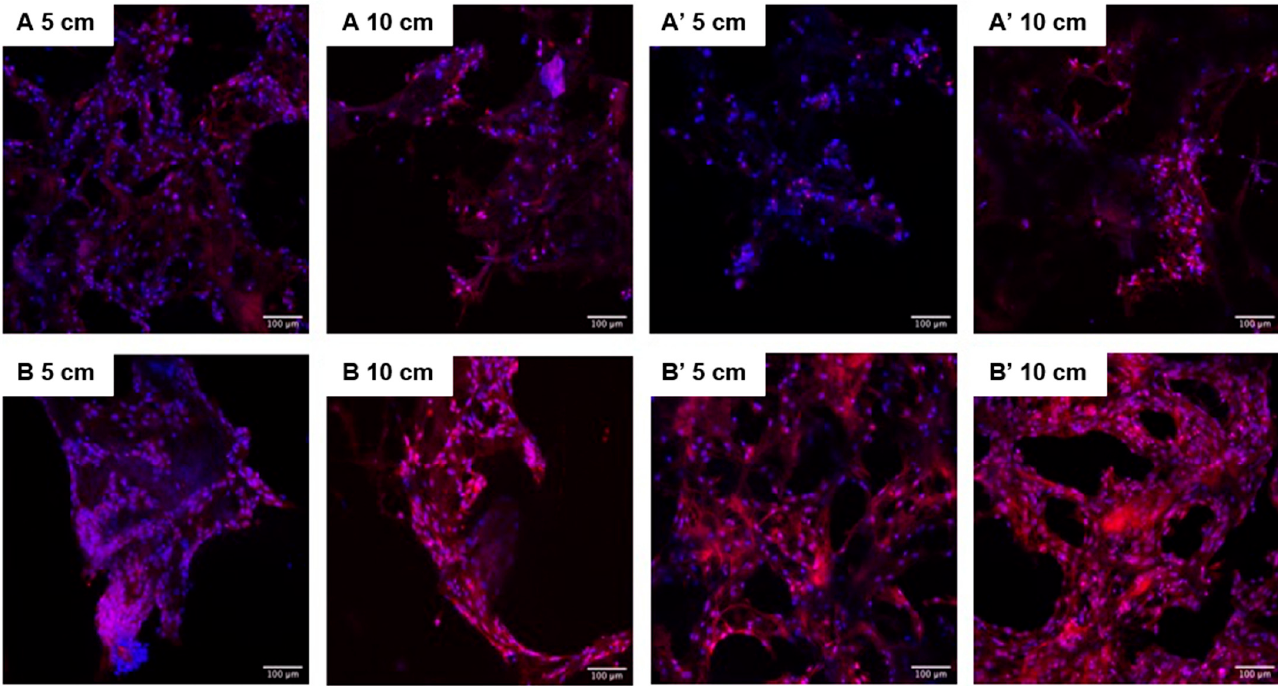
Figure 8. CLSM images of MG63 cultured for 21 days on scaffolds A, B, A’ and B’ with different sizes. Scale bar: 100 μ m.